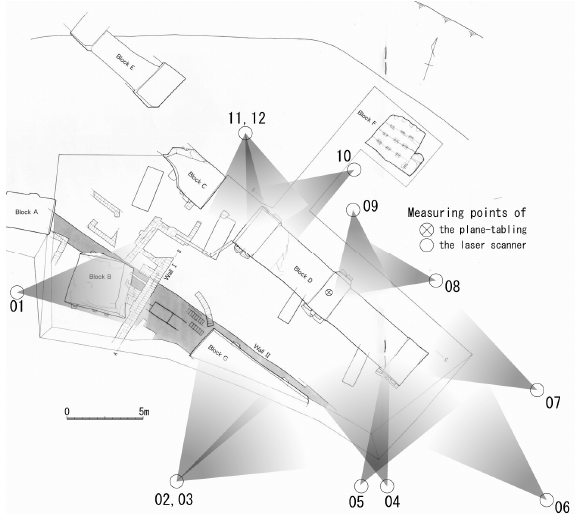
Figure 2. Measuring points of the laser scanner and the plane